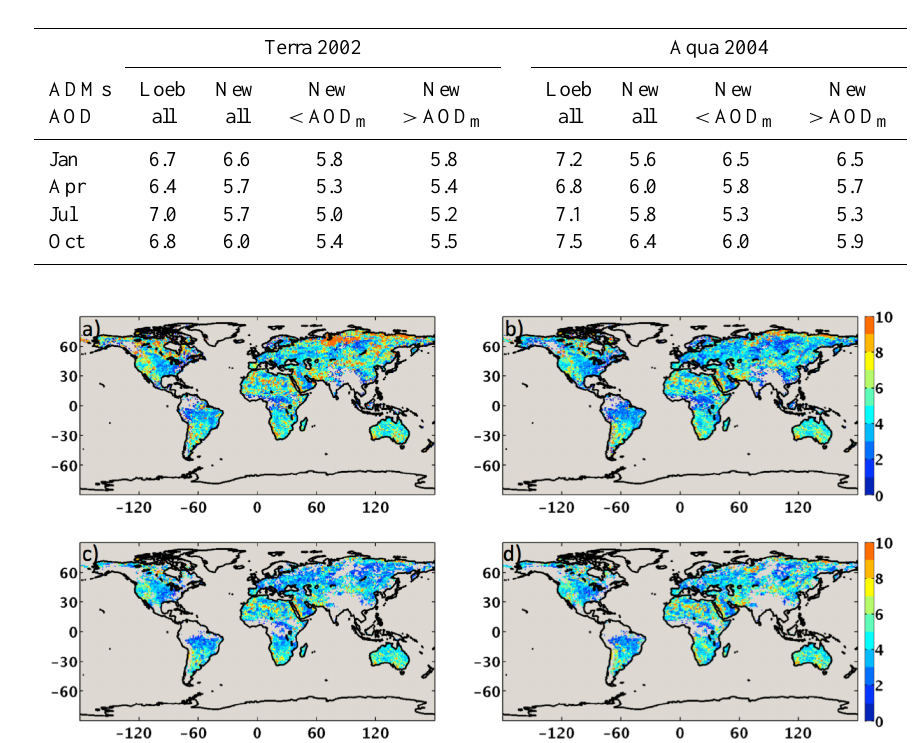
Table 1. The rms error (%) between normalized measured radiances and ADM-predicted radiances over clear-sky land. Two versions of CERES ADMs are used (Loeb and New). The new ADM results are stratified into two populations by using the median aerosol optical depth (AOD m ) of each 1 ◦ by 1 ◦ region.